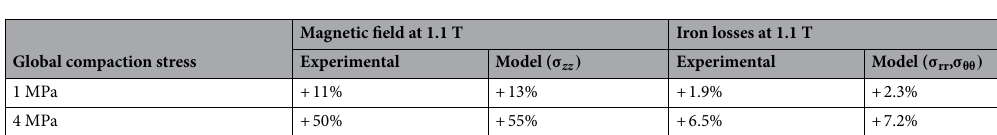
Table 5. Effect of the heterogeneous compaction on the magnetic field and iron losses at 1.1 T. Comparison between the experimental and simulation results—the relative difference (in %) is given compared to the case without